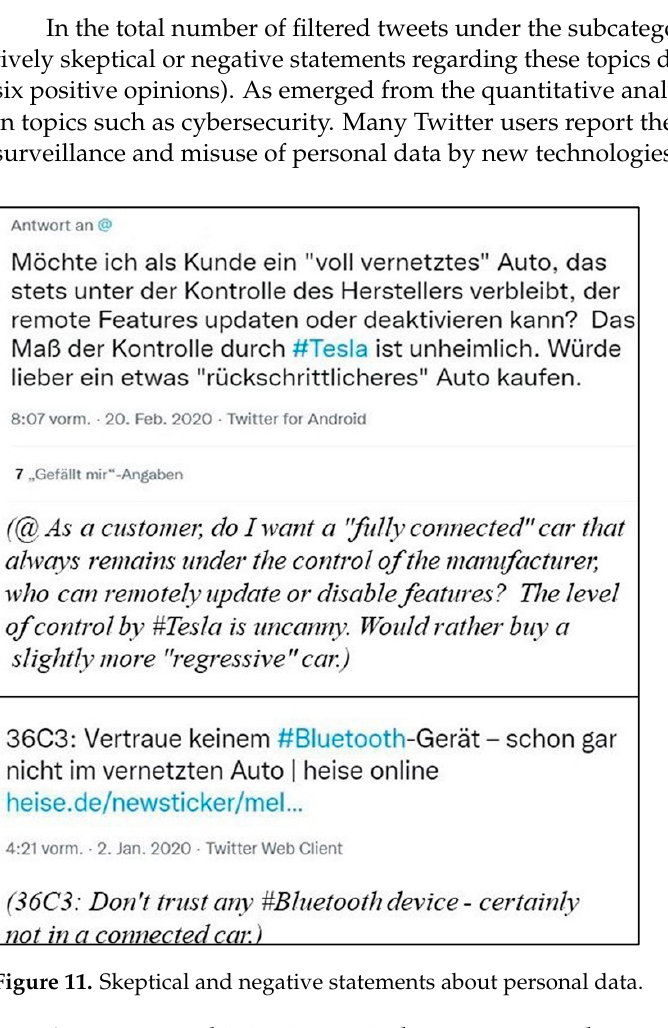
Figure 10. Statement about convenience from autonomous driving.